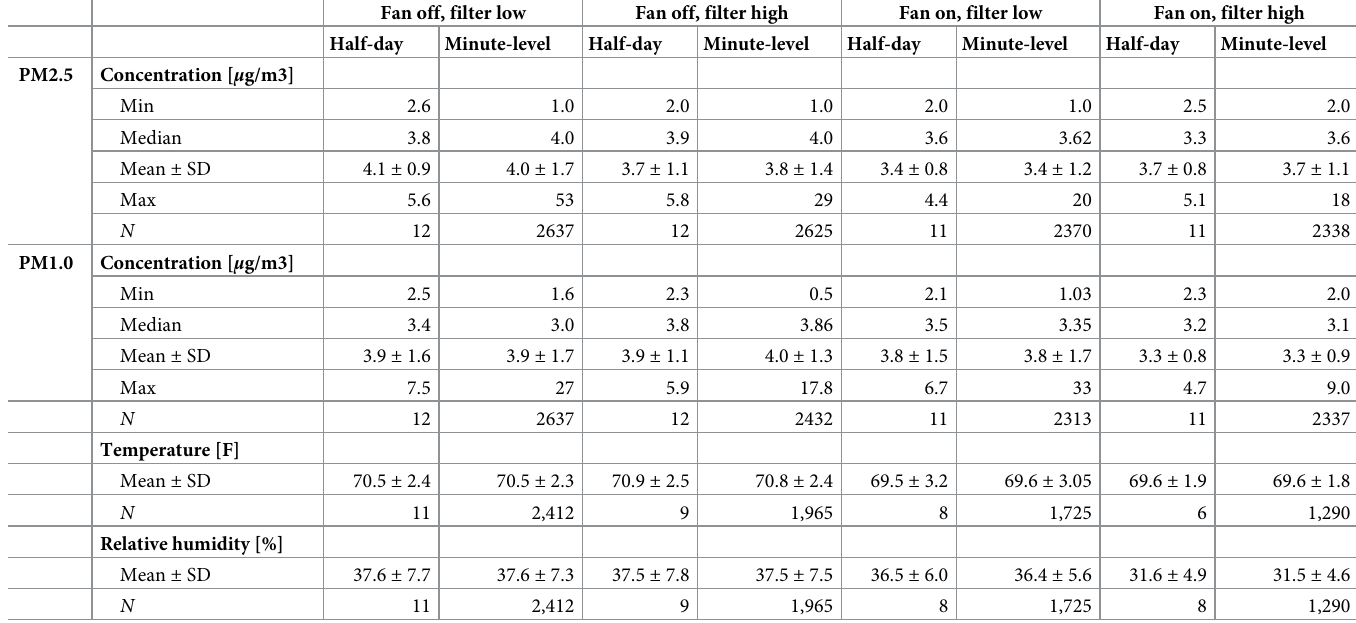
Table 1. Distributions of PM2.5, PM1.0, temperature and relative humidity under different scenarios of HEPA cleaner and air conditioning unit fan use in elemen- tary school classrooms in Rhode Island, USA.